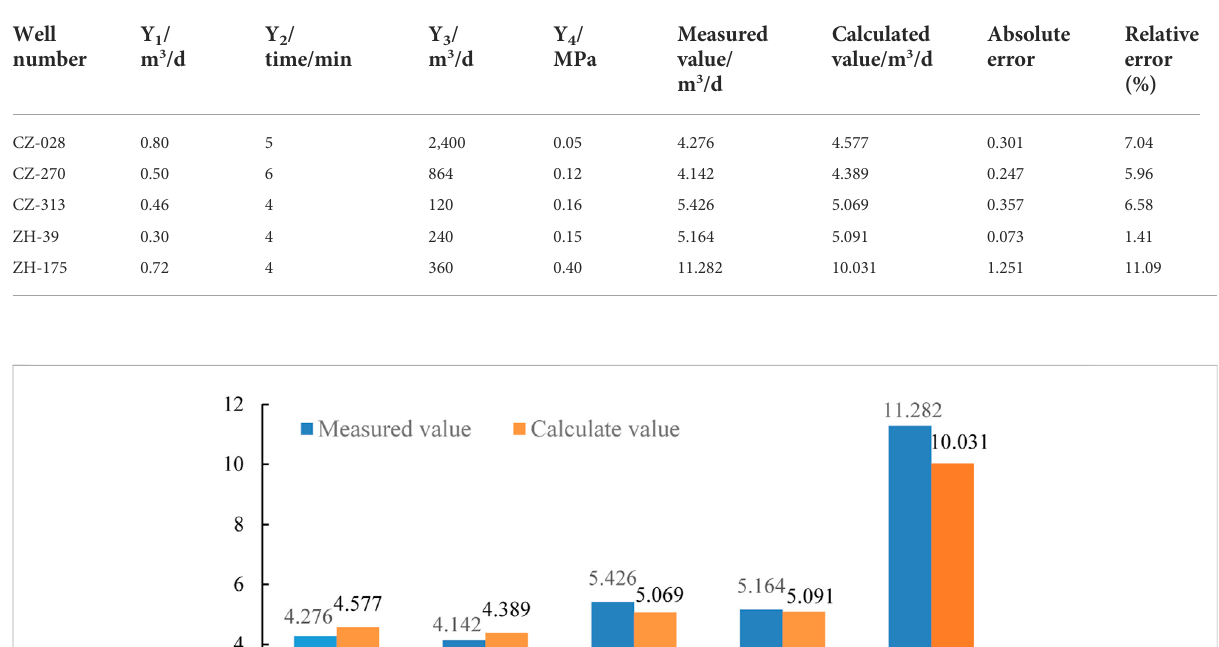
TABLE 6 Calculation results of methane emission model (the single-phase gas fl ow stage).